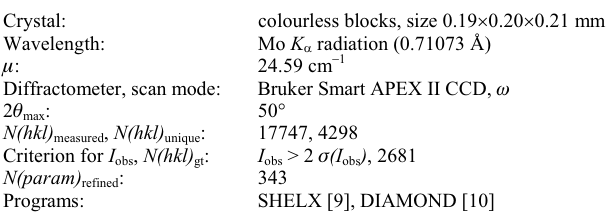
Table 1. Data collection and handling.